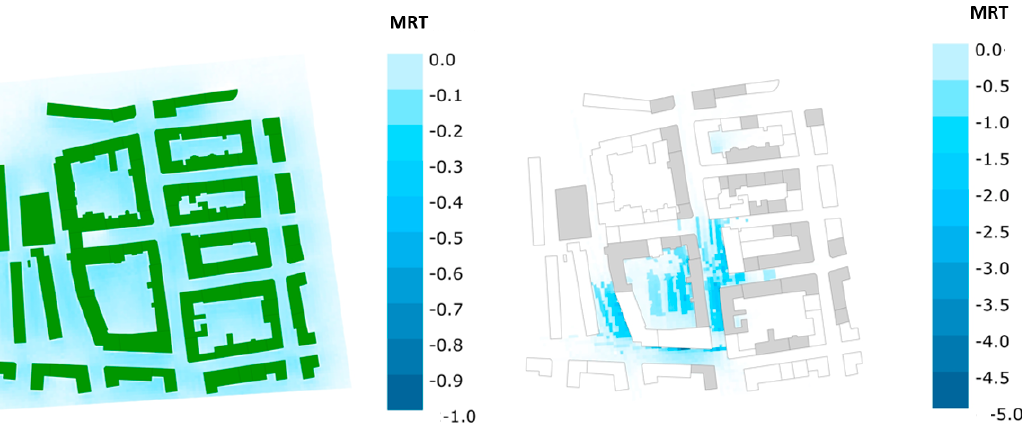
Figure 13. Twenty-four-hour MRT at street level for the smaller sample area with densification with additional green roofs ( left ) and green facades ( right ).